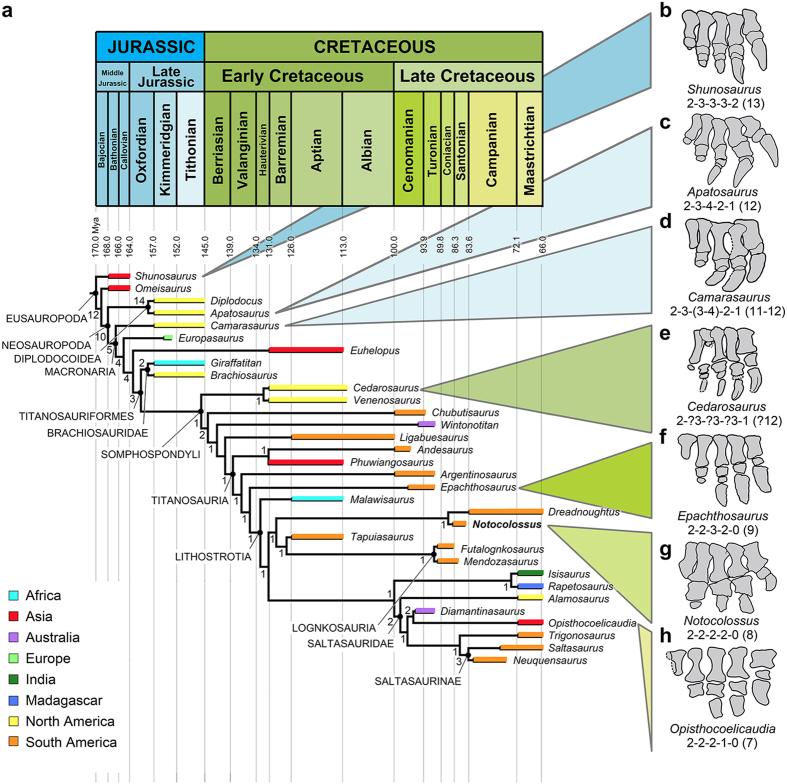
Hypothesized phylogenetic position of Notocolossus gonzalezparejasi and pedal evolution of Sauropoda.(a) Time-calibrated hypothesis of phylogenetic relationships of Notocolossus with relevant clades labelled. Depicted topology is that of the single most parsimonious tree of 720 steps in length (Consistency Index = 0.52; Retention Index = 0.65). Stratigraphic ranges (indicated by coloured bars) for most taxa follow Lacovara et al.4: fig. 3 and references therein. Additional age sources are as follows: Apatosaurus55, Cedarosaurus58, Diamantinasaurus59, Diplodocus35, Europasaurus35, Ligabuesaurus35, Neuquensaurus60, Omeisaurus55, Saltasaurus60, Shunosaurus55, Trigonosaurus35, Venenosaurus58, Wintonotitan59. Stratigraphic ranges are colour-coded to also indicate geographic provenance of each taxon: Africa (excluding Madagascar), light blue; Asia (excluding India), red; Australia, purple; Europe, light green; India, dark green; Madagascar, dark blue; North America, yellow; South America, orange. (b–h) Drawings of articulated or closely associated sauropod right pedes in dorsal (=anterior) view, with respective pedal phalangeal formulae and total number of phalanges per pes provided (the latter in parentheses). (b) Shunosaurus (ZDM T5402, reversed and redrawn from Zhang45); (c) Apatosaurus (CM 89); (d) Camarasaurus (USNM 13786); (e) Cedarosaurus (FMNH PR 977, reversed from D’Emic32); (f) Epachthosaurus (UNPSJB-PV 920, redrawn and modified from Martínez et al.22); (g) Notocolossus; (h) Opisthocoelicaudia (ZPAL MgD-I-48). Note near-progressive decrease in total number of pedal phalanges and trend toward phalangeal reduction on pedal digits II–V throughout sauropod evolutionary history (culminating in phalangeal formula of 2-2-2-1-0 [seven total phalanges per pes] in the latest Cretaceous derived titanosaur Opisthocoelicaudia). Abbreviation: Mya, million years ago. Institutional abbreviations see Supplementary Information.